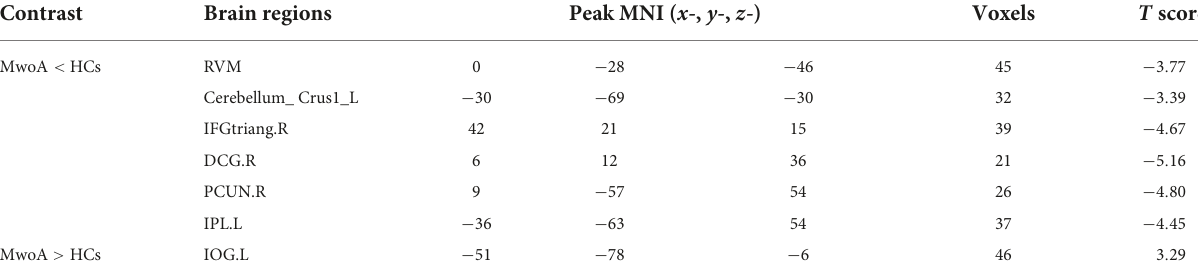
TABLE 2 Brain regions with increased and decreased dALFF variability in migraine compared with healthy controls at the